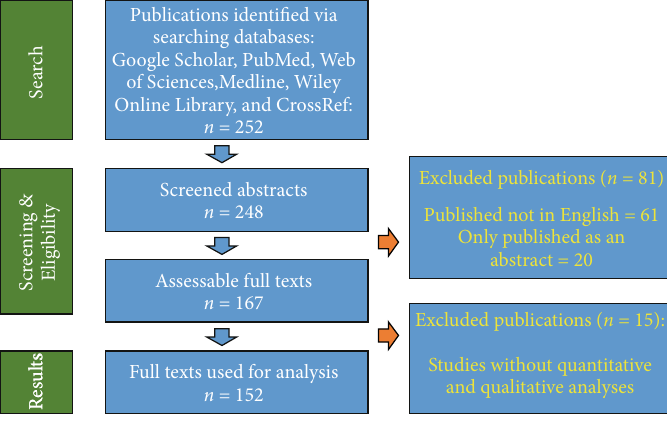
Figure 2: Flow chart summarizing the search process and